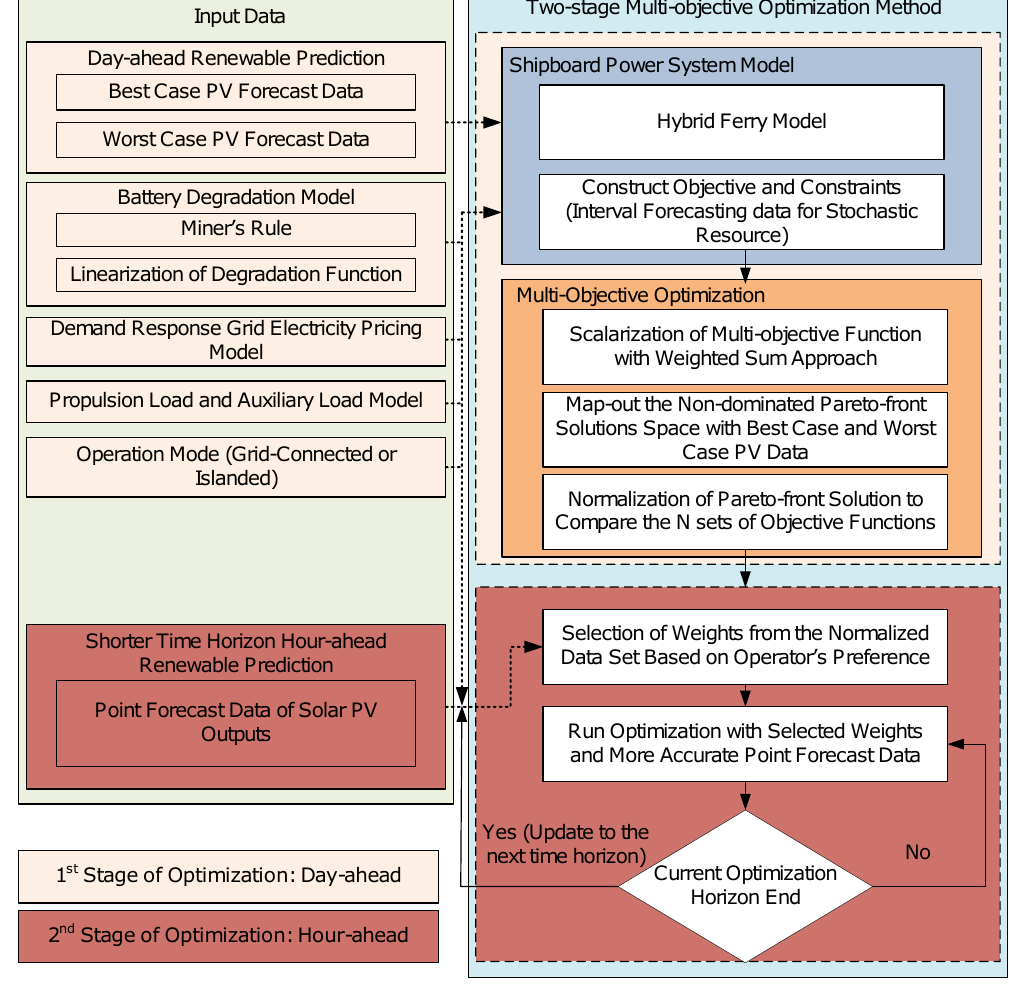
Figure 1. Proposed framework for multi-objective optimization in hybrid